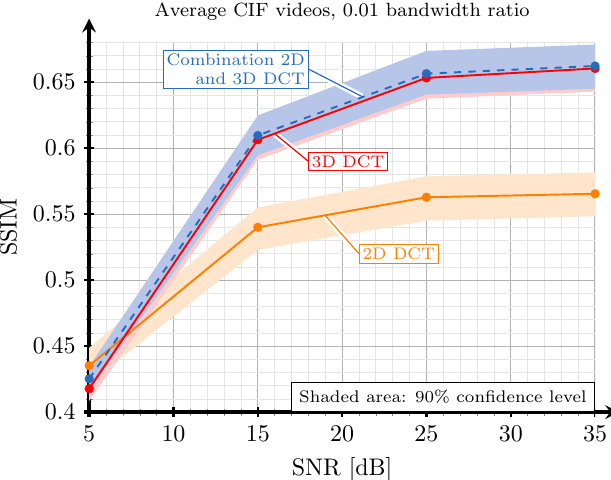
Shaded area: 90% confidence